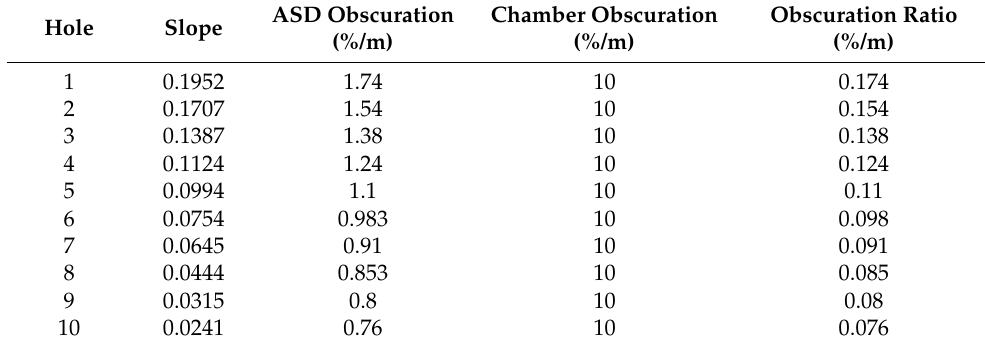
Table 8. The slope and obscuration ratio at ASD 1 when chamber obscuration is 15%/m. Hole